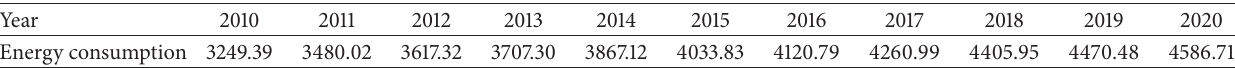
Table 3: Forecast of China’s energy consumption from 2010 to